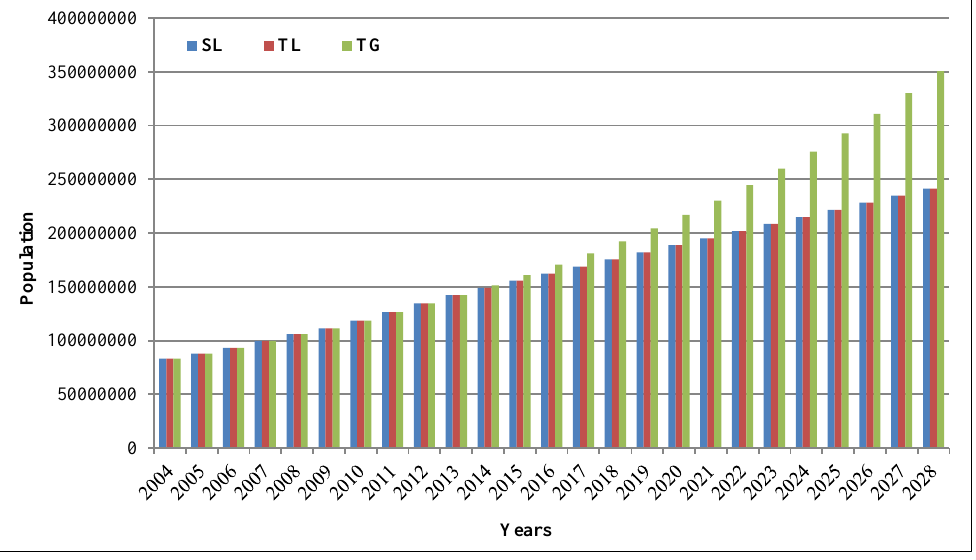
Figure 4. Graph of economic test